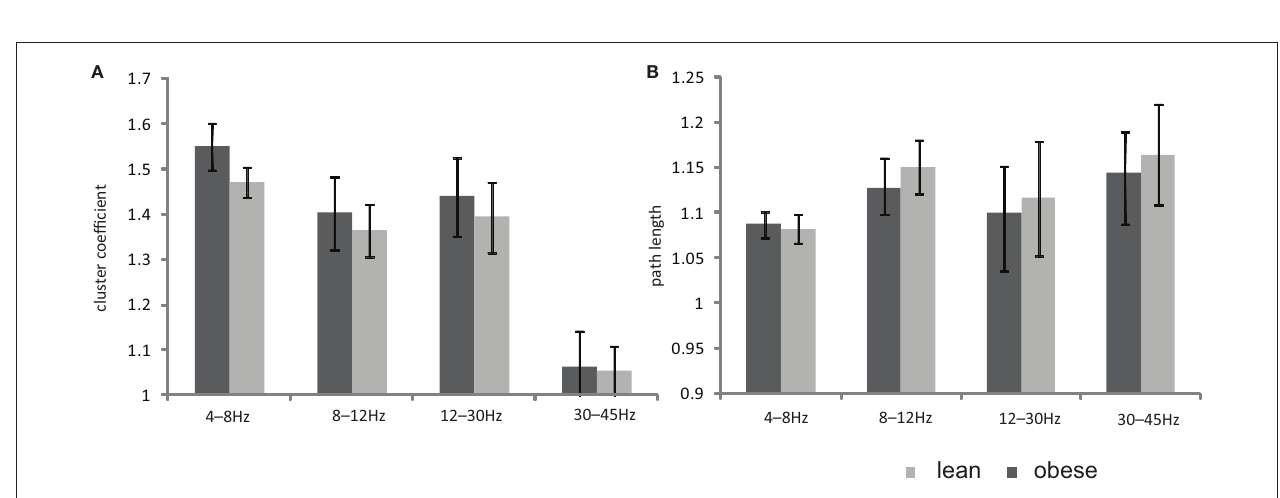
FiGurE 1 | Bar plot of reliability measurements by inter intra class correlation (iCC, calculated for mixed model, type consistency and averaged measures) for different frequency ranges for normalized cluster coefficient (C) and normalized path length (L, * p < 0.05, ** p < 0.01, *** p < 0.001).